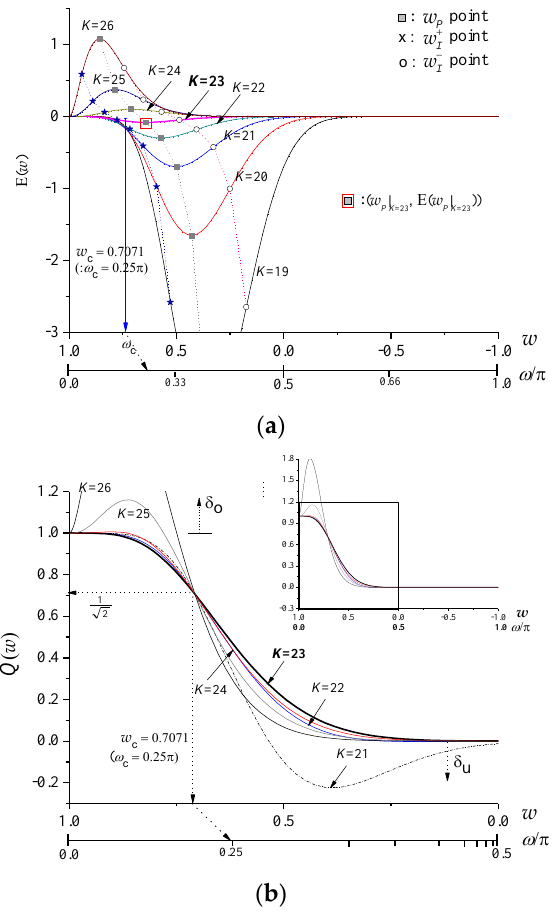
Figure 4. ( a ) Ε(𝑤) and ( b ) the effect of the related Ε(𝑤) on 𝑄(𝑤) due to increasing 𝐾 for 𝑁 = 28 and 𝑤 𝑐 = 0.7071 ( 𝜔 𝑐 = 0.25𝜋 ).